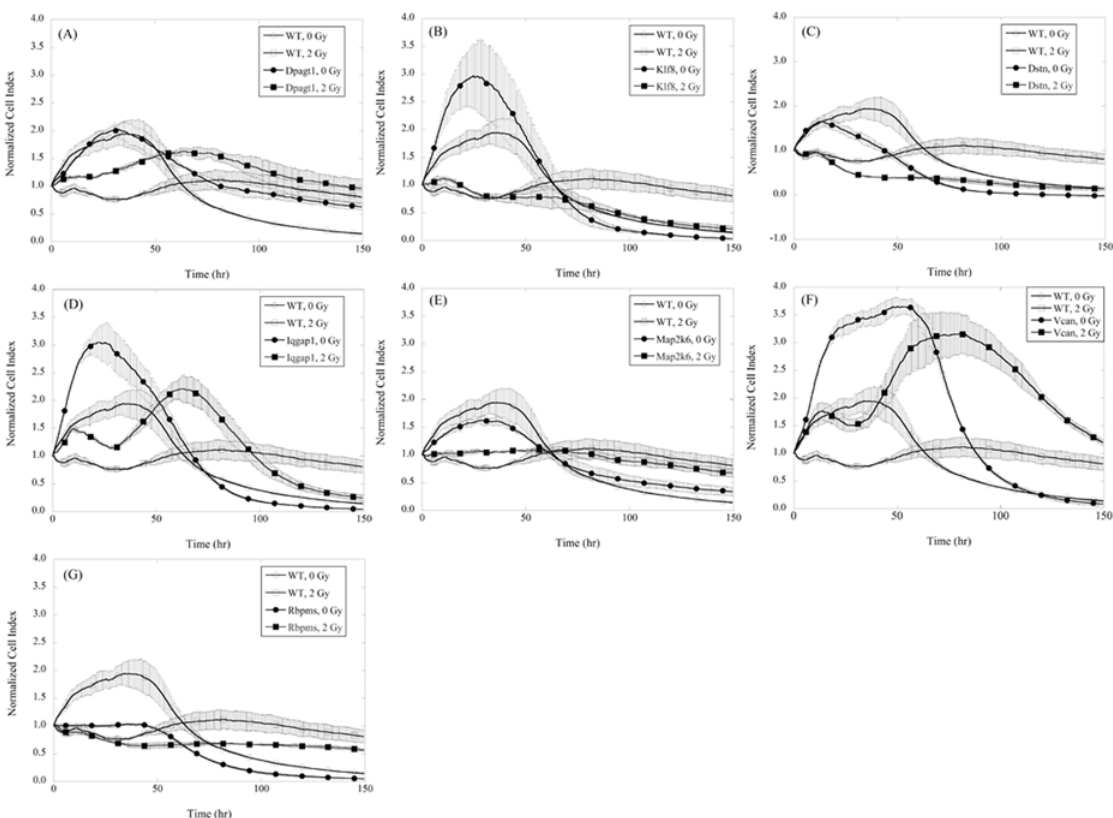
Fig 3. Cell growth as a function of time for wild type (WT) and (A) Dpagt1-mutant ESCs, (B) Klf8-mutant ESCs, (C) Dstn-mutant ESCs, (D) Iqgap1-mutant ESCs, (E) Map2k6-mutant ESCs, (F) Vcan-mutant ESCs, (G) Rbpms-mutant ESCs. Cells were irradiated with a dose of 2-Gy just before incubation using x-rays. Error bars indicate